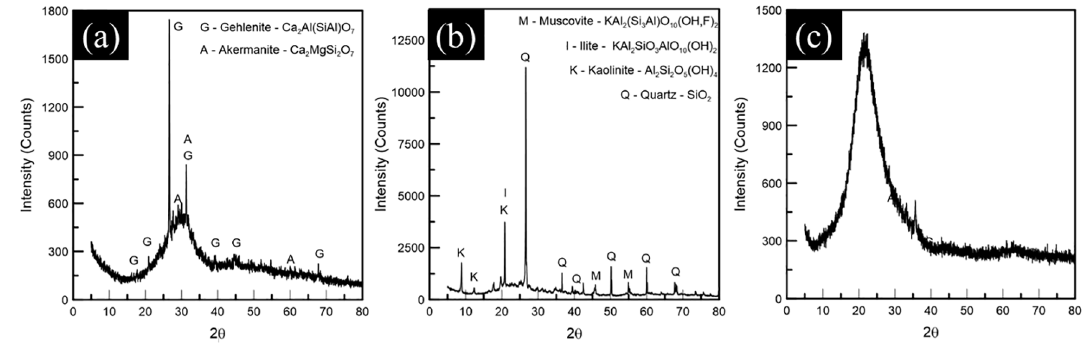
Figure 3. Diffractograms of: a) blast furnace slag; b) metakaolin; and c) silica fume.